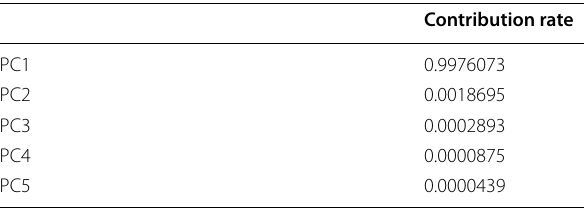
PC1 accounts for more than 99.7% of contribution